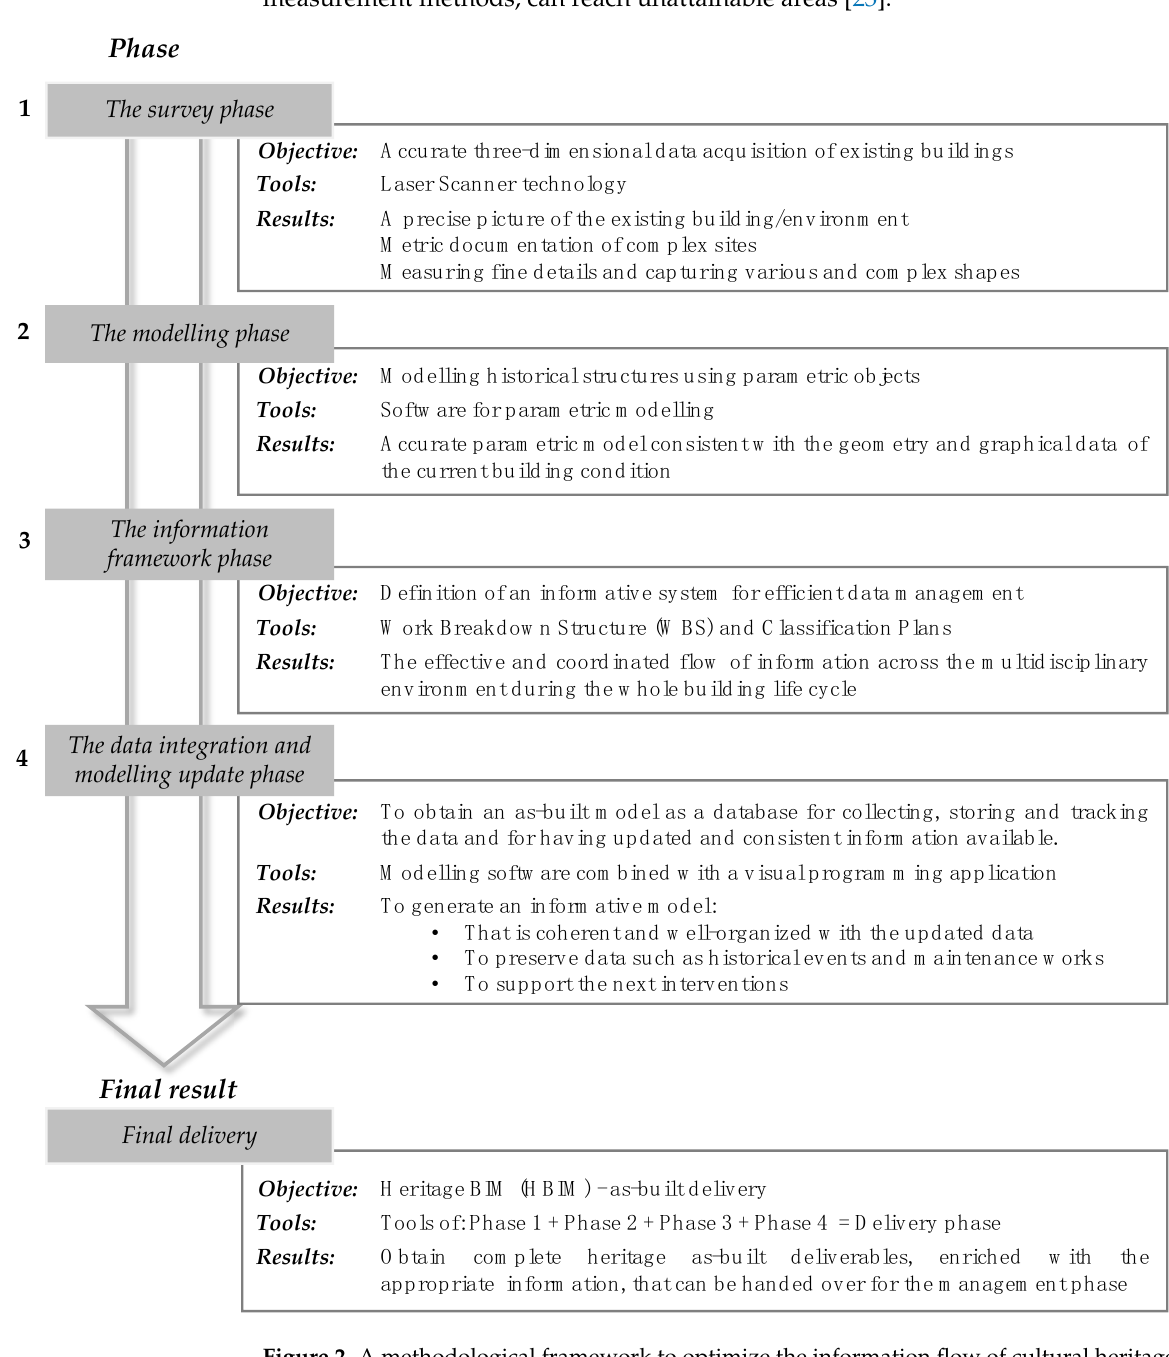
Figure 2. A methodological framework to optimize the information flow of cultural heritage. The laser scanner tool allows for the remote identification of the morphology of an architectural structure through the laser, which reaches the surface to be detected. For this reason, it is considered a non-destructive system. This aspect is of higher importance in the context of heritage buildings. The three-dimensional laser scanner is directed to the physical element to be scanned, and the laser beam is addressed to the object in a space grid of points. The result is a point cloud made of thousands of points in a three-dimensional space. The point cloud generated can have different densities based on the scanner settings, and, regarding the level of detail requested, it is consistent with the next